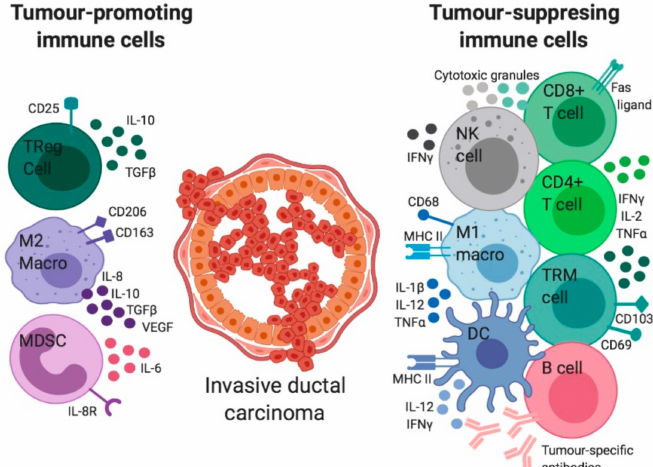
Figure 3. The immune microenvironment of invasive ductal carcinoma. Subsets of the immune system can elicit both tumour-promoting and tumour-suppressing e ff ects. Immune inhibition of tumours is largely driven by the activity of CD8 + T cells, CD4 + T cells, Tissue-resident T (T RM ) cells, B cells, Natural Killer (NK) cells, M1 macrophages and dendritic cells (DC). The tumour-fighting immune landscape produces cytokines that inhibit tumour development (including IFN γ , TNF α , IL-1 β , IL-2 and IL-12). CD8 + T cells and NK cells also secrete cytotoxic granules that trigger tumour cell apoptosis. Similarly, B cells secrete tumour-specific antibodies that target tumour cells for elimination. In contrast, the immune stimulation of tumours is promoted by Regulatory T (TReg) cells, M2 macrophages and Myeloid-derived suppressor cells (MDSCs), which act to suppress their anti-tumour immune counterparts and facilitate tumour growth. These cells release immuno-inhibitory pro-tumour cytokines (TGF β , VEGF, IL-6, IL-8 and IL-10)